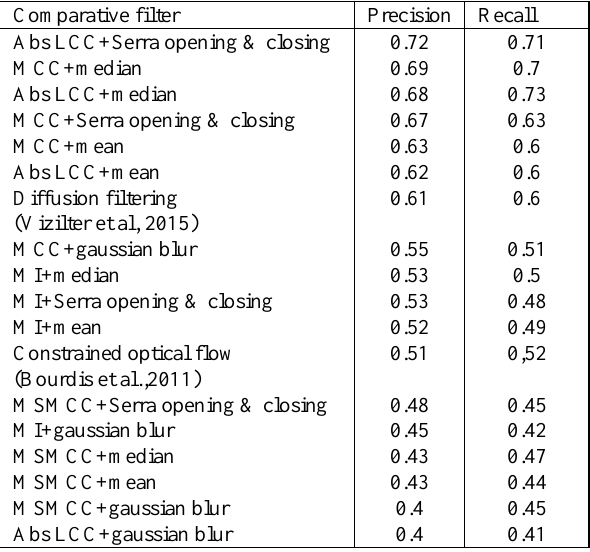
Table 1. Results of quantitative